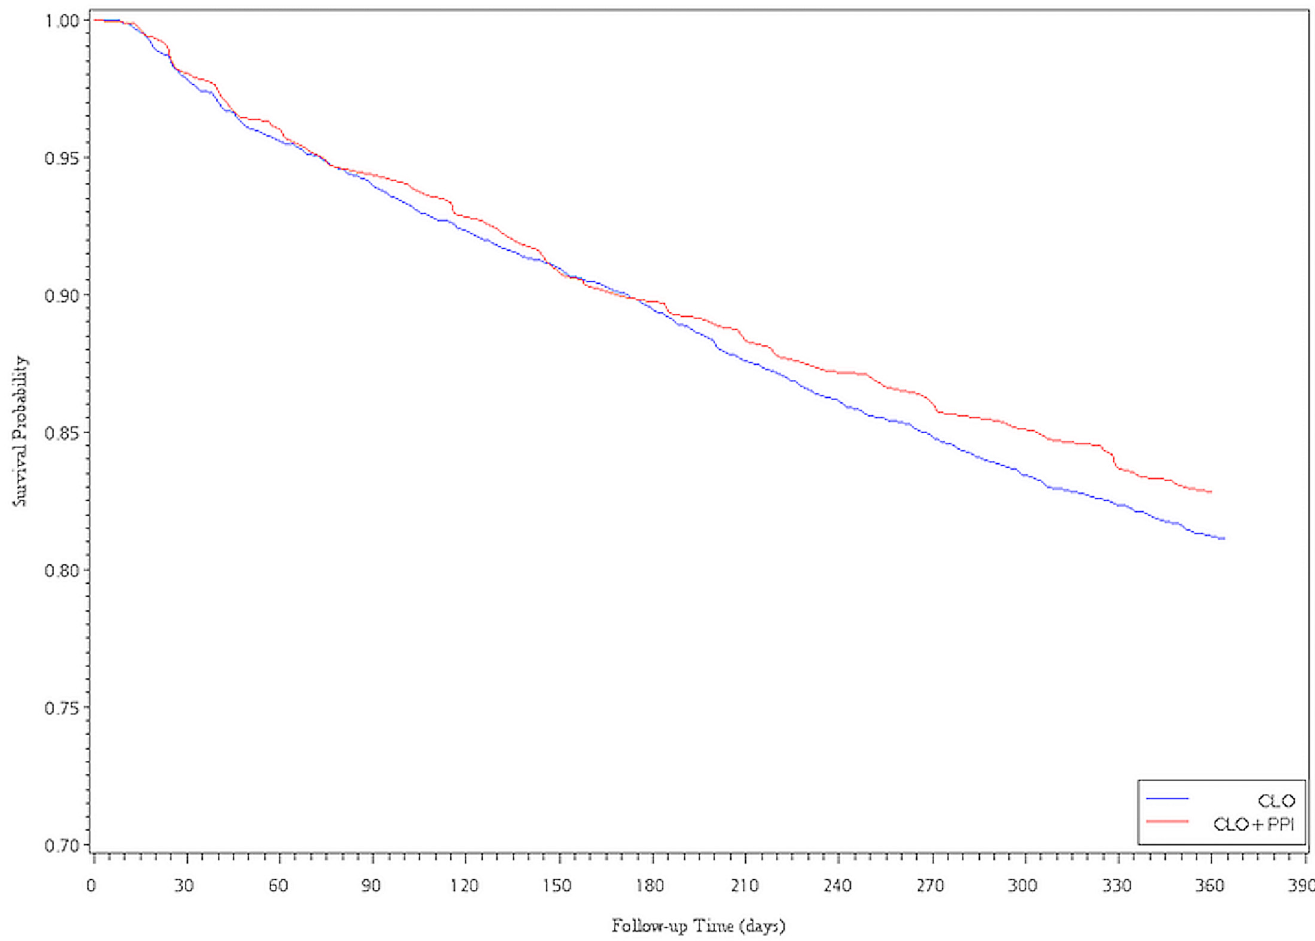
Fig 1. Survival analysis of revascularization versus exposure to ClO plus PPI and ClO after LES implantation.